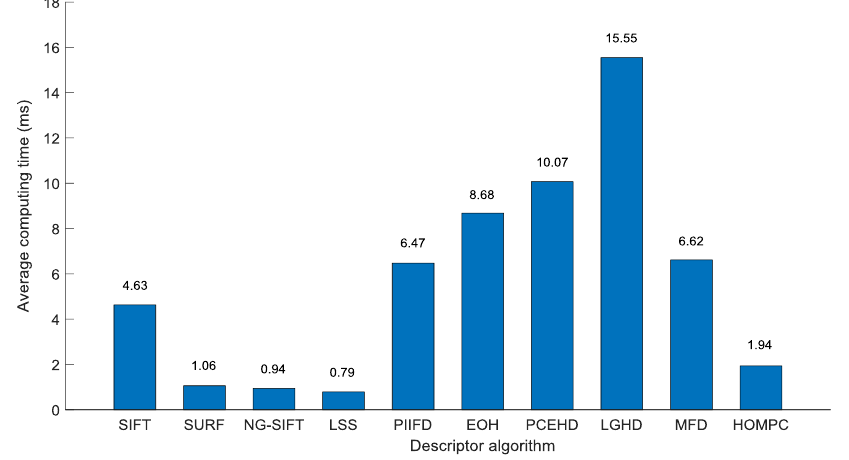
Figure 22. The average computation time per a feature point using different descriptor. The HOMPC is our descriptor.